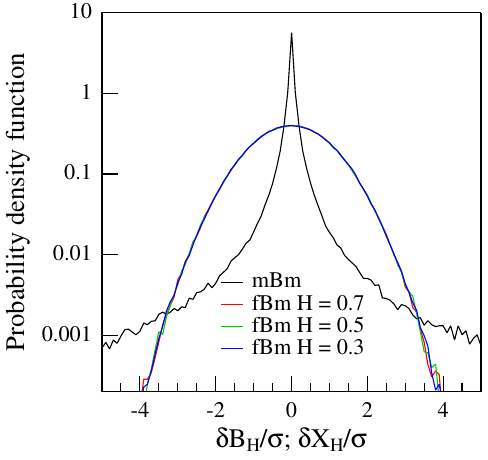
Fig. 4. Comparison among the PDFs of variance normalized increments, δB H ( τ ) and δX H ( t ) ( τ ) , of the mBm and fBms reported in previous figures. The shape of the function for the fBms is the same for all H values. Fig. 6. The geomagnetic field horizontal intensity H , as recorded at L’Aquila geomagnetic Observatory (Italy) in 2001 (upper panel) and 2008 (lower panel).